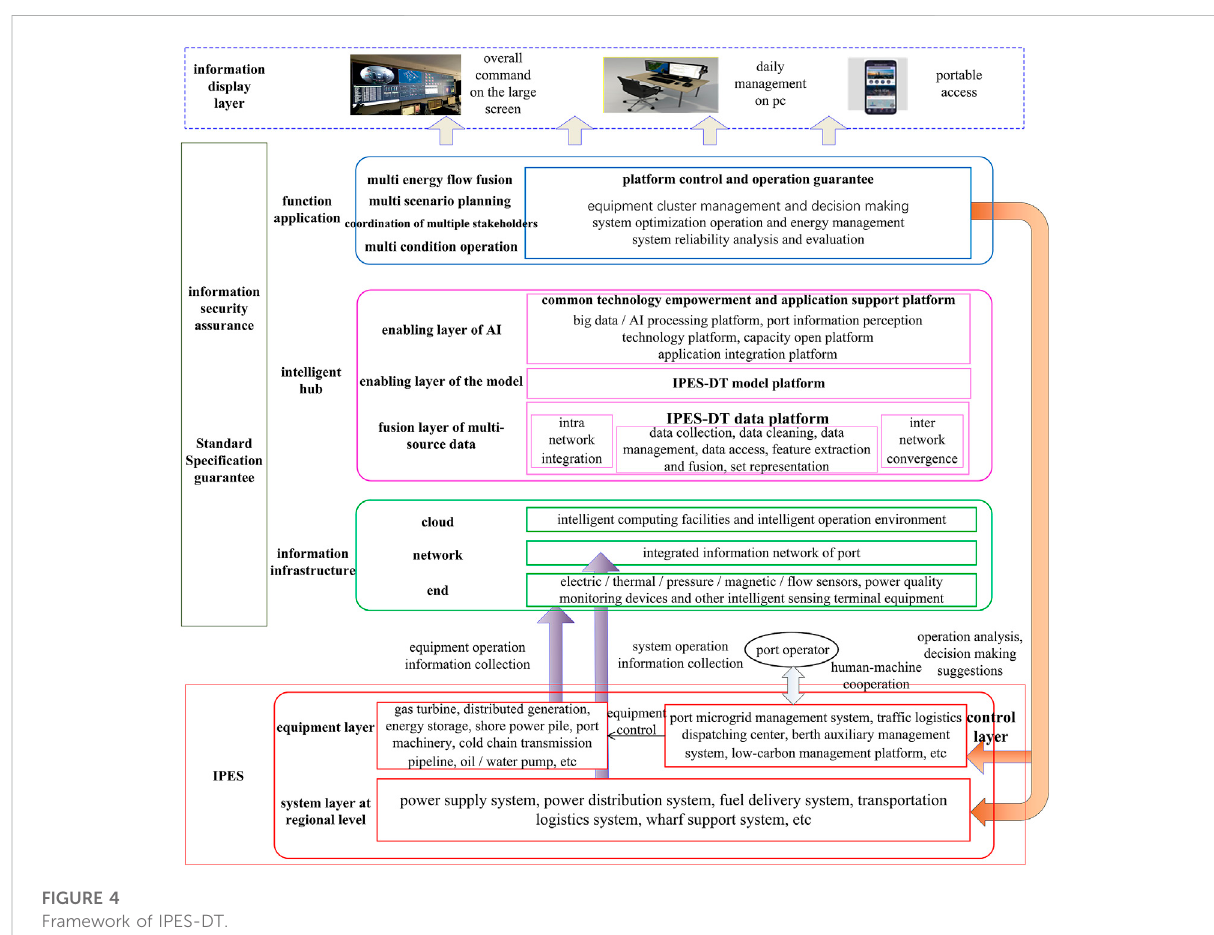
FIGURE 4 Framework of